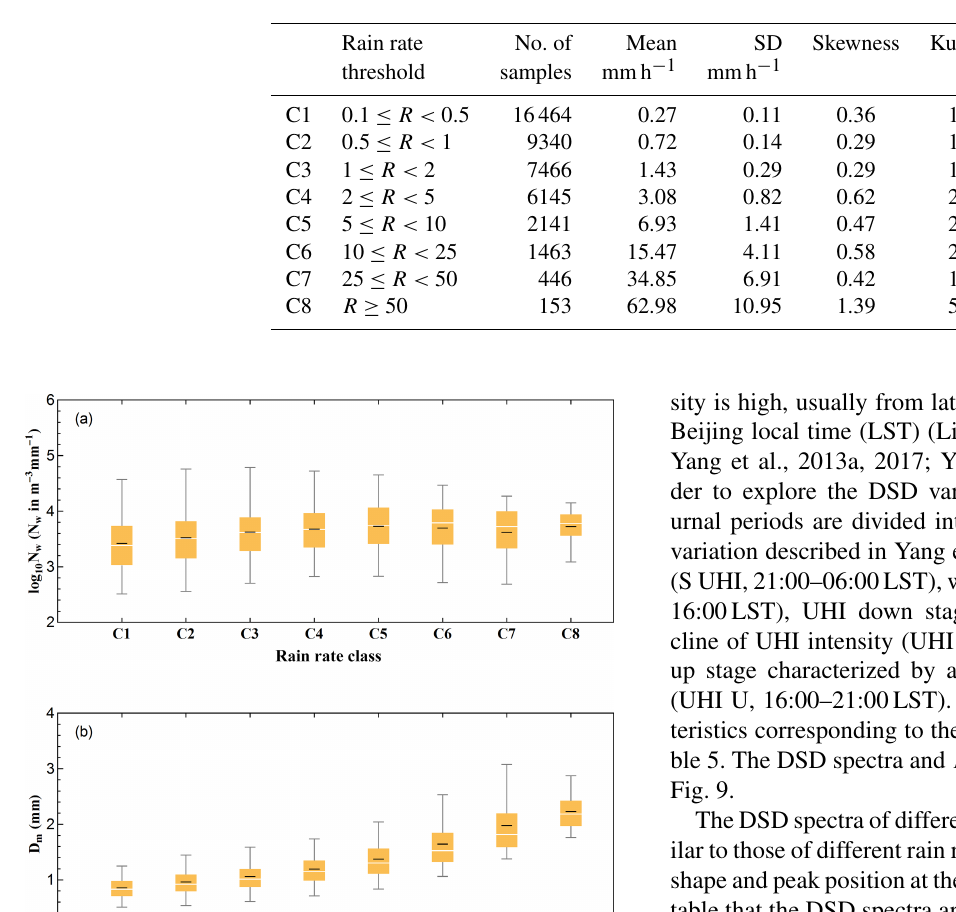
Table 3. Number and DSD retrieved rain rate statistics of each rain rate class.